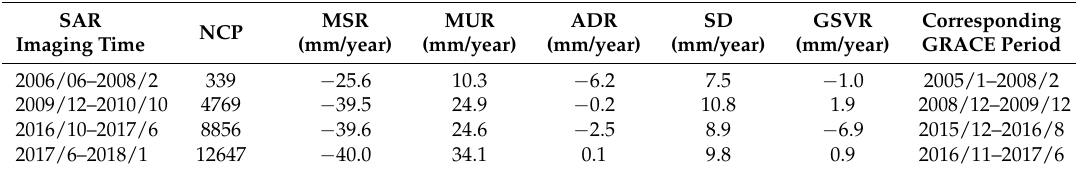
Table 4. Deformation information and groundwater storage variation rate.